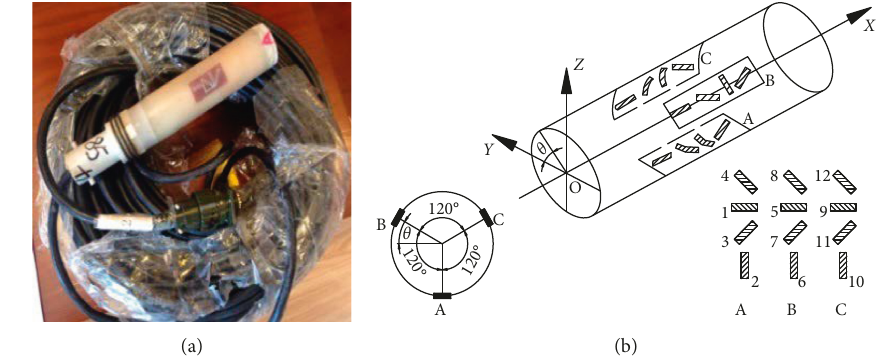
Figure 3: KX-2000 hollow inclusion strain sensors. (a) Strain sensor probe. (b) Internal structure of the strain sensor